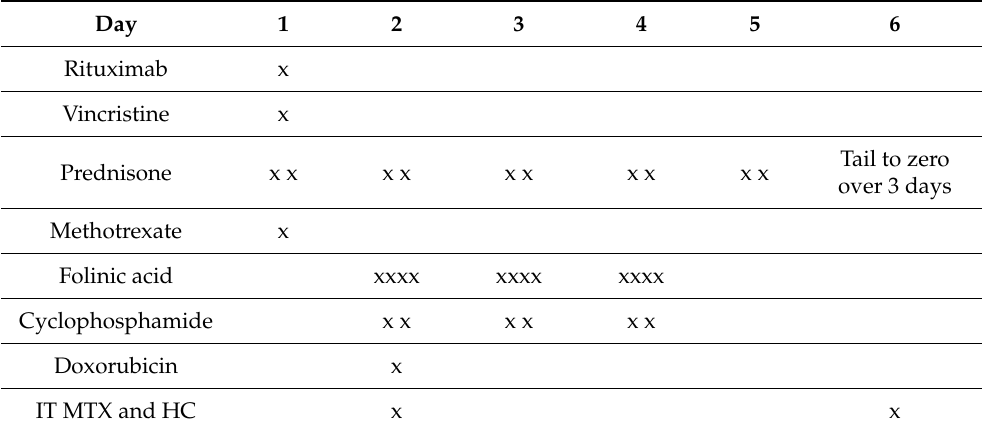
Table 2. Treatment according to the B-HR arm of the Inter-B-NHL-COP 2010 with dose reduction of methotrexate and cyclophosphamide, without methotrexate dose escalation — Pre-Phase COP.